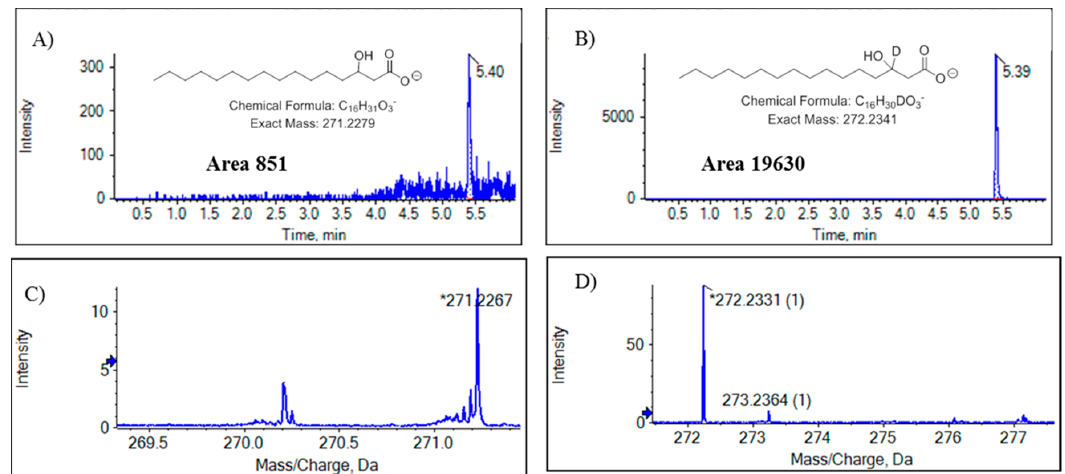
Figure 2. Extracted ion chromatograms for m / z 272.2341 ( A ) and m / z 271.2279 ( B ) and their Figure2. Extractedionchromatogramsfor m / z 272.2341( A )and m / z 271.2279( B )andtheircorresponding corresponding mass spectra ( C ) and ( D ). mass spectra ( C ) and ( D